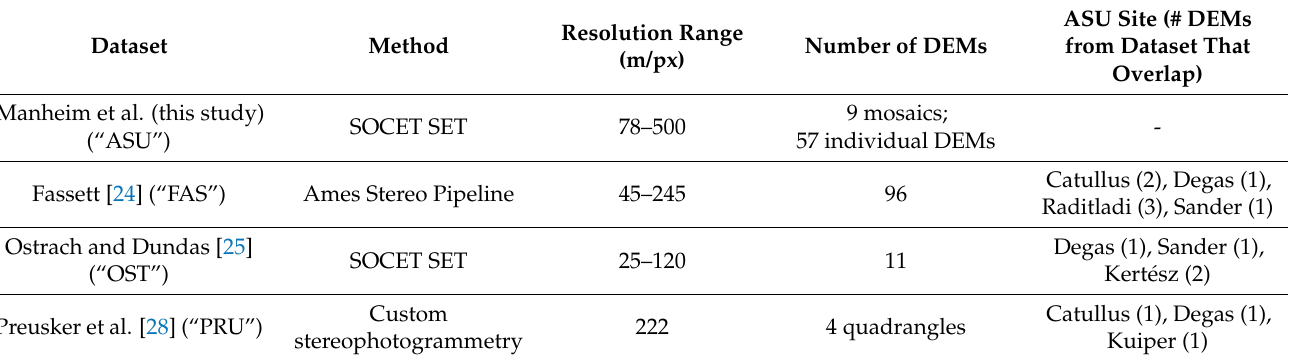
Table 4. Regional MDIS DEM datasets used in this comparison.